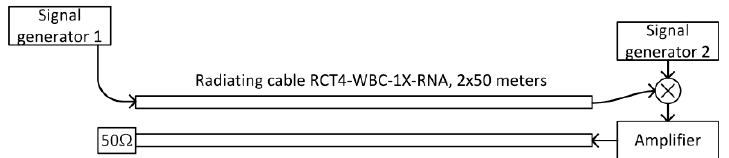
Figure 6. Measuring stand with the frequency conversion of the return signal.